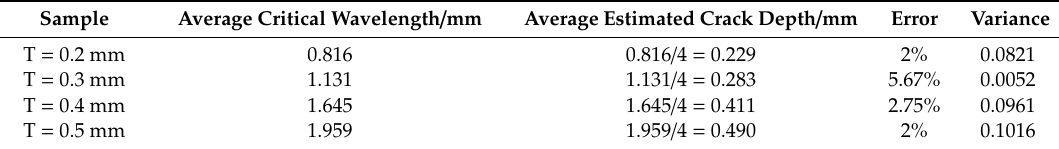
Table 9. Average values and variance for estimated crack